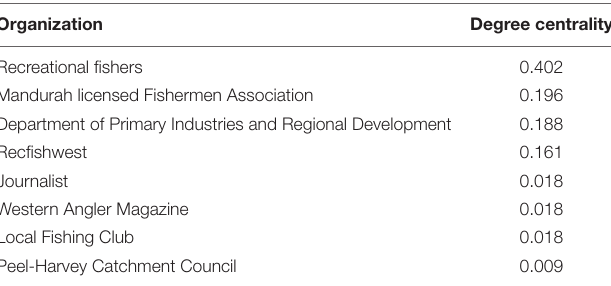
Degree centrality prestige